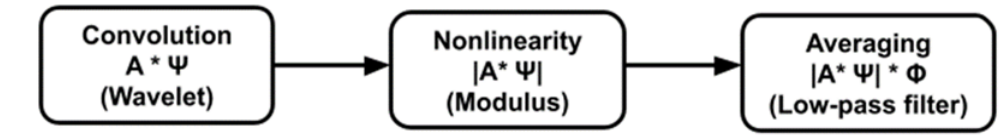
Figure 5. Wavelet scattering transform stages where A represents an image, Ψ a wavelet function and Φ an averaging low-pass filter [36] .